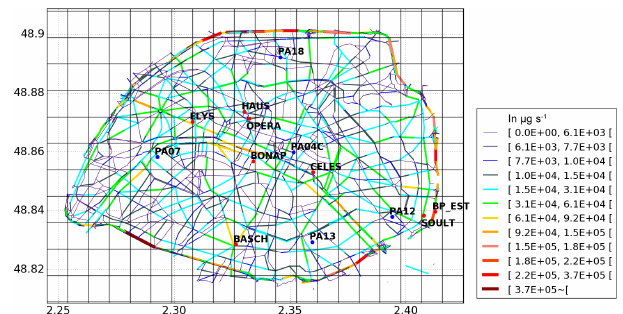
Figure 6. Street network with the regional-scale grid mesh and the position of the measurement